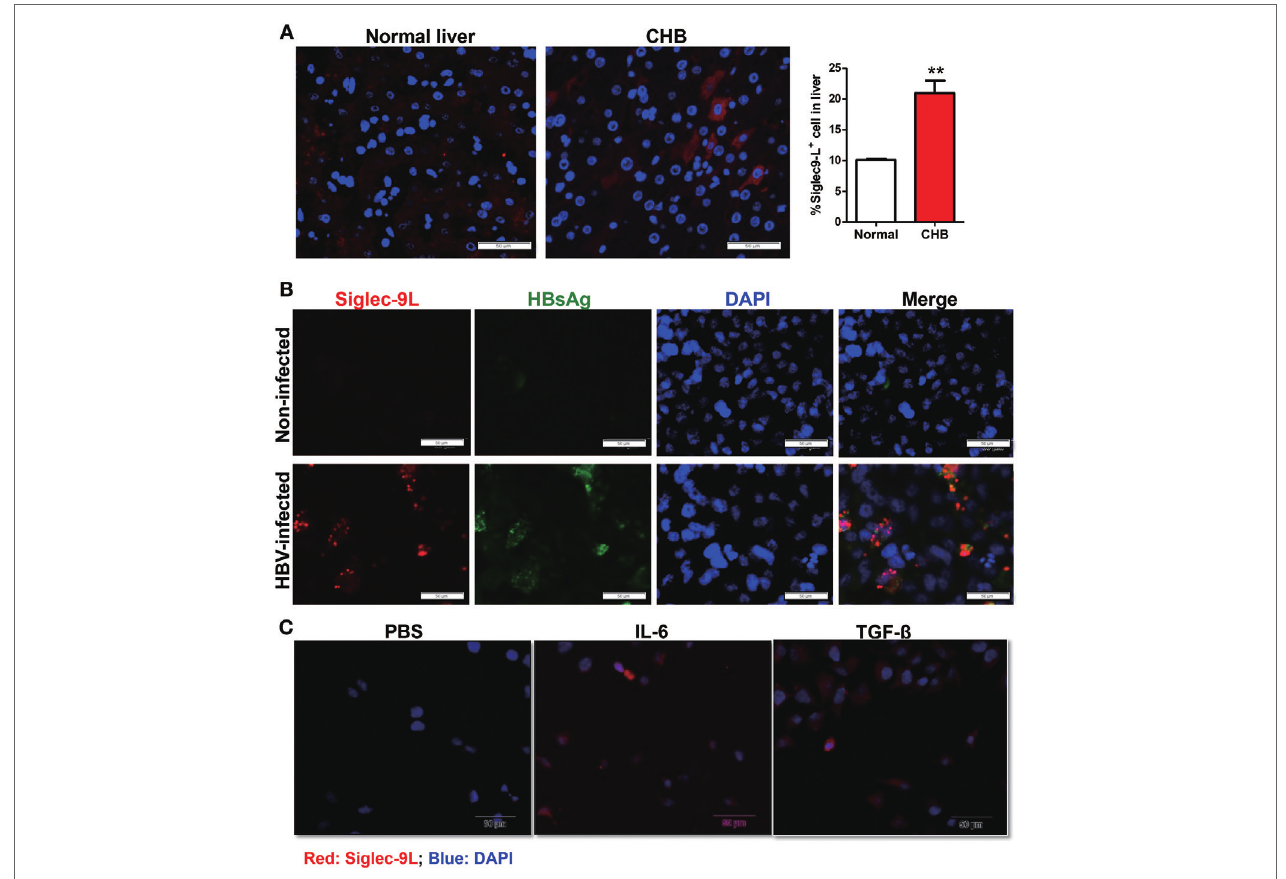
FigUre 6 | Upregulated expression of Siglec-9 ligand in HBV infection and inflammatory milieu. (a) Detection of Siglec-9 ligand in liver biopsies from chronic hepatitis B (CHB) patients or normal liver tissues by immunofluorescence using Siglec-9-Fc chimera protein. (B,c) Expression of Siglec-9 ligand and hepatitis B surface antigen (HBsAg) in hepatoma cell line HLCZ01 with or without HBV infection (B) , and Huh7 cells treated with 100 ng/ml IL-6 or TNF- α for 24 h (c) , was evaluated by immunofluorescence